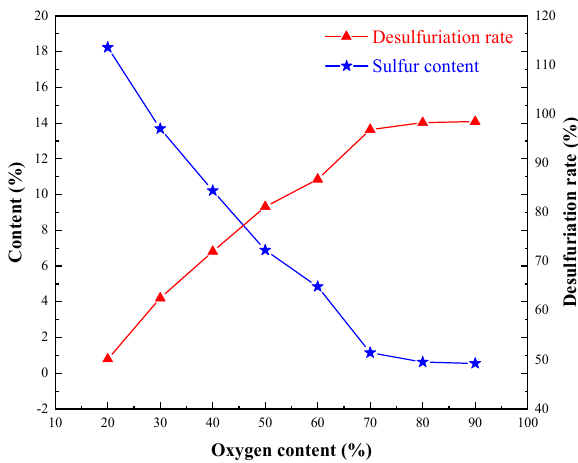
Figure 5. E ff ect of oxygen content on sulfur removal. Figure 5. Effect of oxygen content on sulfur removal. Figure 5. Effect of oxygen content on sulfur removal.